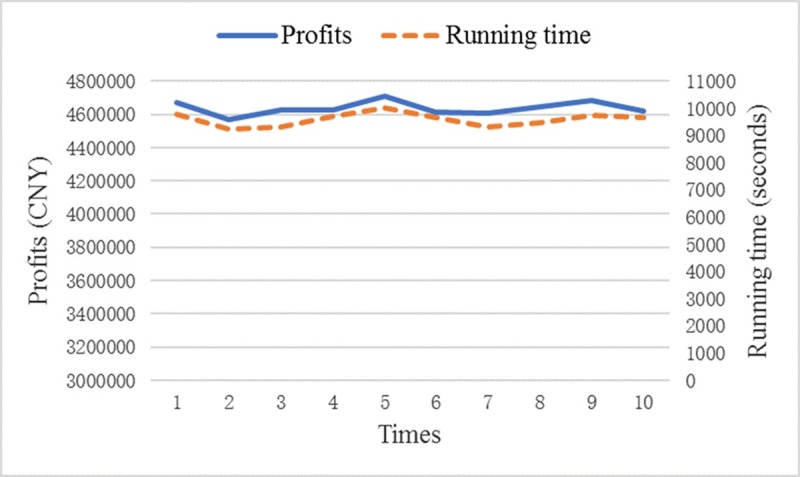
Results of IPSO.